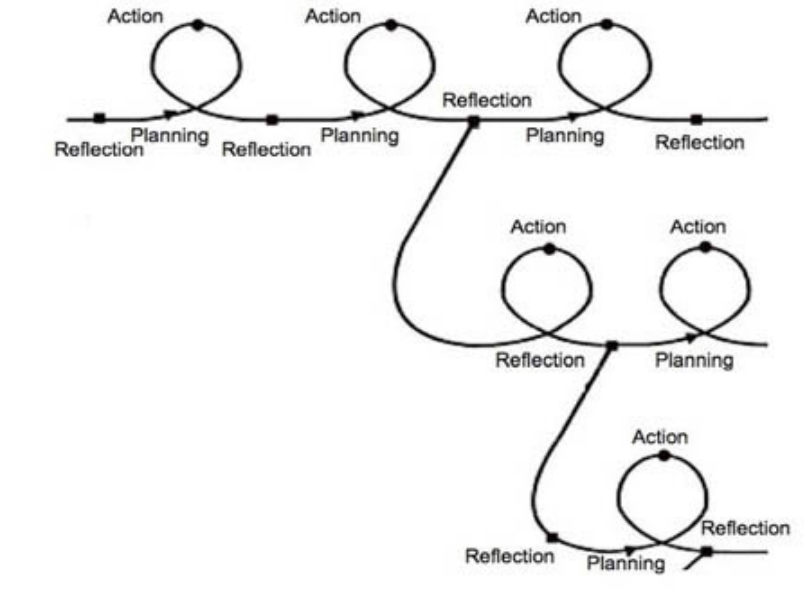
Fig. 4. Nodes of reflection, triggering new learning loops in an ACM process for creating better livelihood options (Hartanto et al.